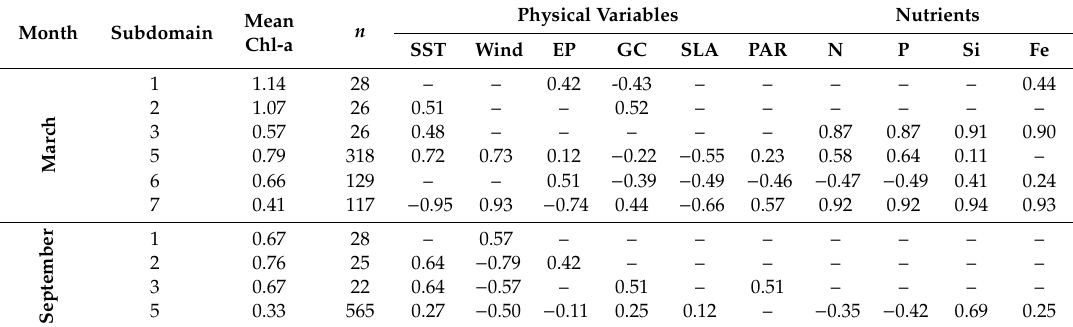
Table 2. Linear Pearson correlations between Chl-a and physical variables and nutrient content in each subdomain and for both periods (March and